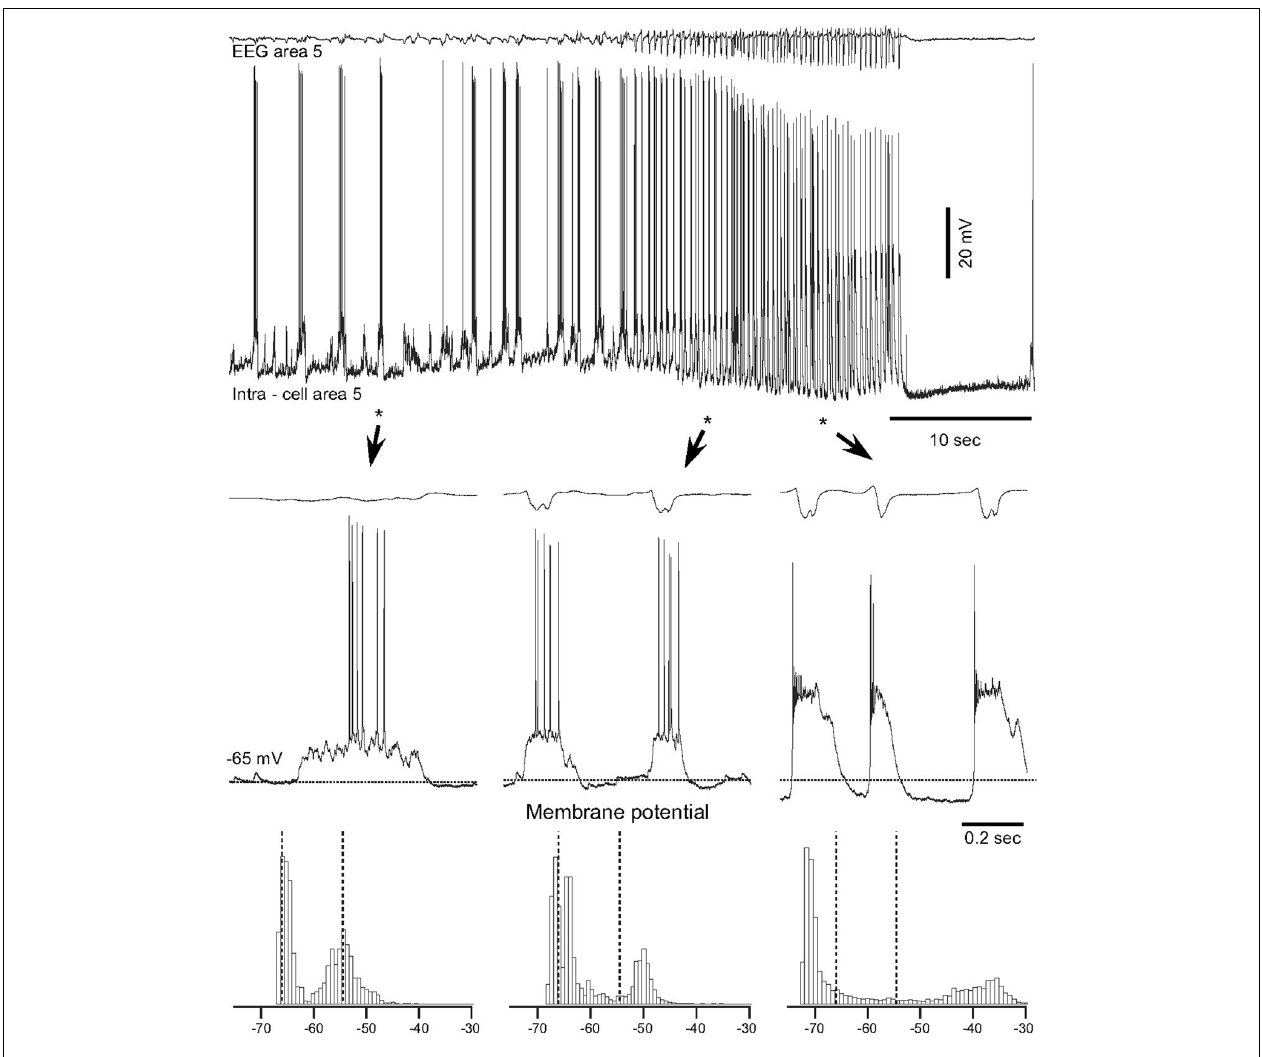
panels indicate the level of membrane potential ( − 65 mV). Bottom panels show histograms of the membrane potential ( V m ) distribution during corresponding periods of seizure. Dotted lines indicate the initial level of V m during the slow oscillation. Note a shift of V m during seizure in both depolarizing and hyperpolarizing directions (Topolnik etal.,